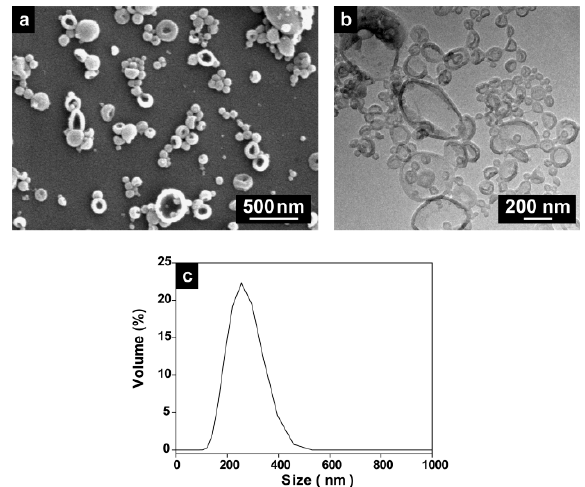
Figure 5. ( a ) SEM, ( b ) TEM, and ( c ) the size distribution of PU NCs prepared using 4,4 ′ -MDI and a mixture of DETA and EDA as the monomers (PU-9). mixture of DETA and EDA as the monomers